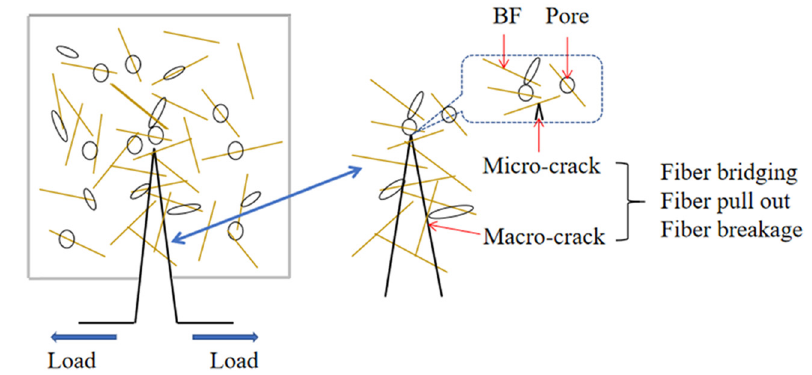
Figure 19: Multi - scale crack resistance process of BFRAC.